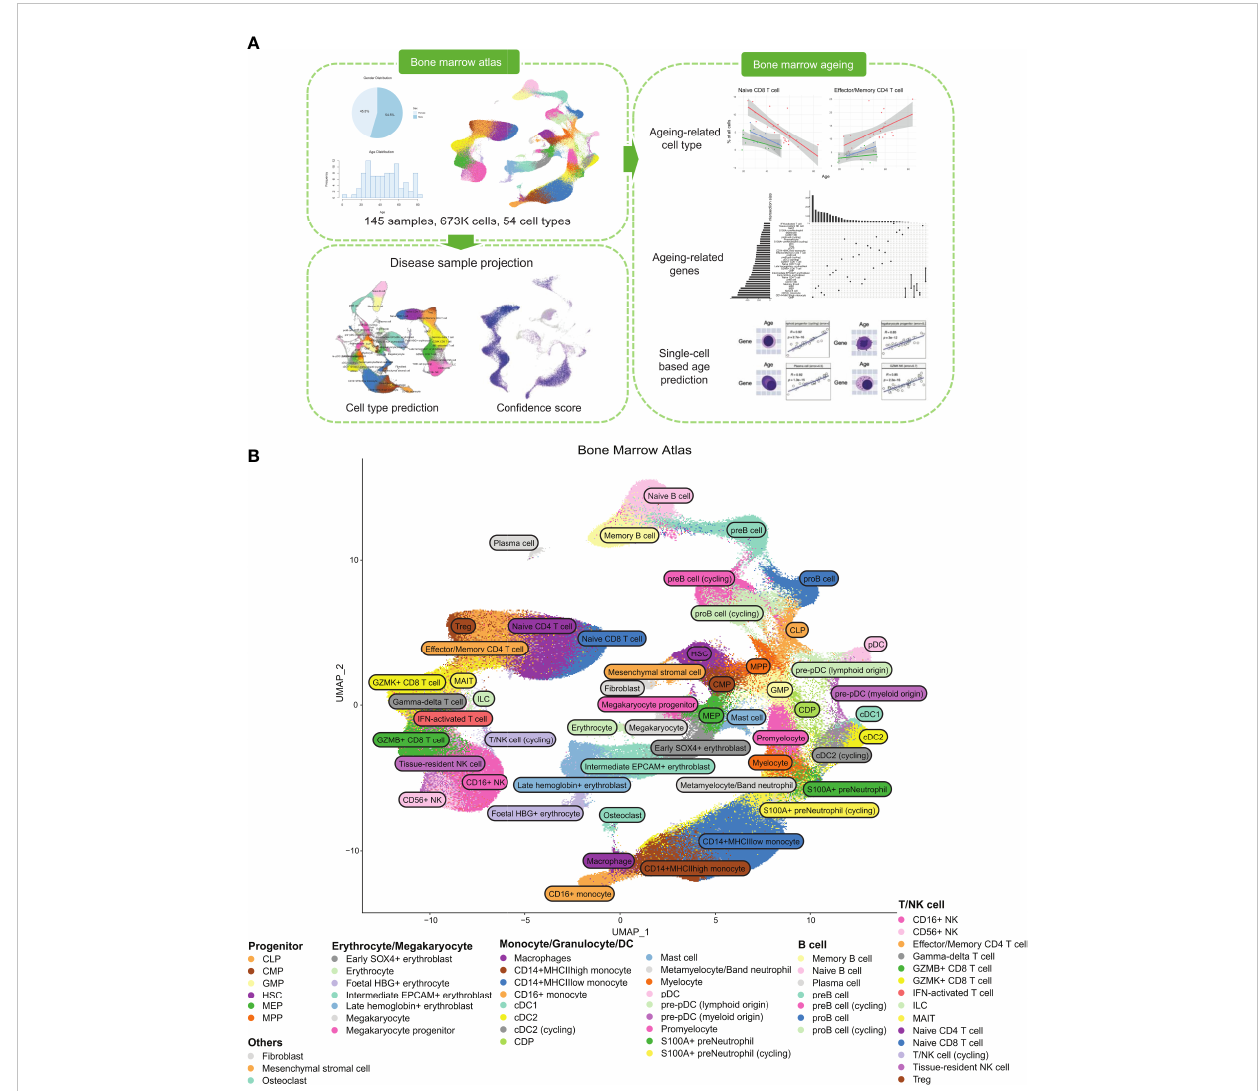
FIGURE 1 Healthy BM atlas construction, annotation, and analysis. (A) Integration and analysis of publicly available healthy BM samples to construct the atlas. 145 healthy BM samples were used to build the fi nal atlas with 673,750 cells in 54 cell types. Blood disease samples of acute myeloid leukaemia and multiple myeloma were projected onto the healthy BM atlas to identify disease-speci fi c populations. Age-correlated cell type frequency changes and associated dysregulated genes and pathways were identi fi ed. Identi fi ed age-associated gene signatures were then used with machine learning to predict cell age. (B) UMAP of the integrated healthy BM atlas with cells coloured by their cell type annotation. For an interactive version of this atlas, please visit DISCO at